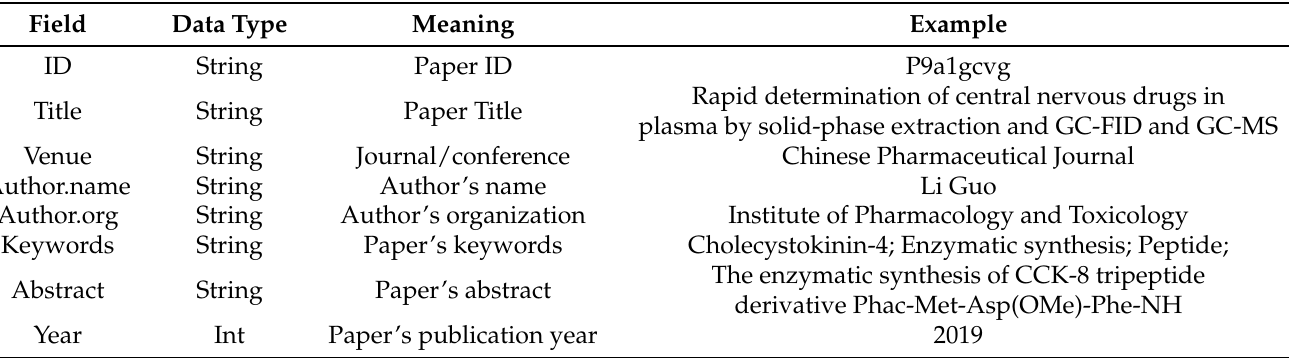
Table 6. Format of academic paper